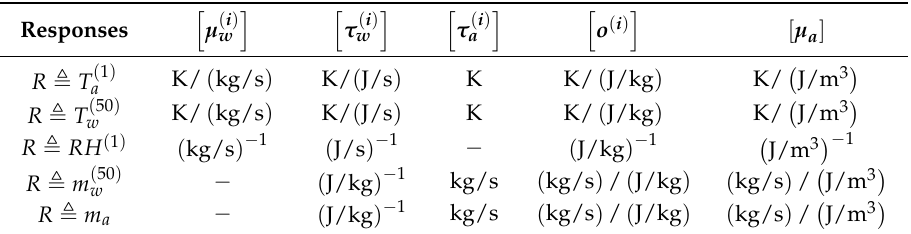
Table 1 below lists the units of the adjoint functions for five responses: R (cid:44) T ( 50 ) (cid:44) m R (cid:44) RH ( 1 ) , R (cid:44) m a , respectively, in which, T w and R denotes exit water temperature; RH ( 1 ) denotes exit air relative humidity; m mass flow rate; and m a denotes air mass flow rate. Table 1. Units of the adjoint functions for different